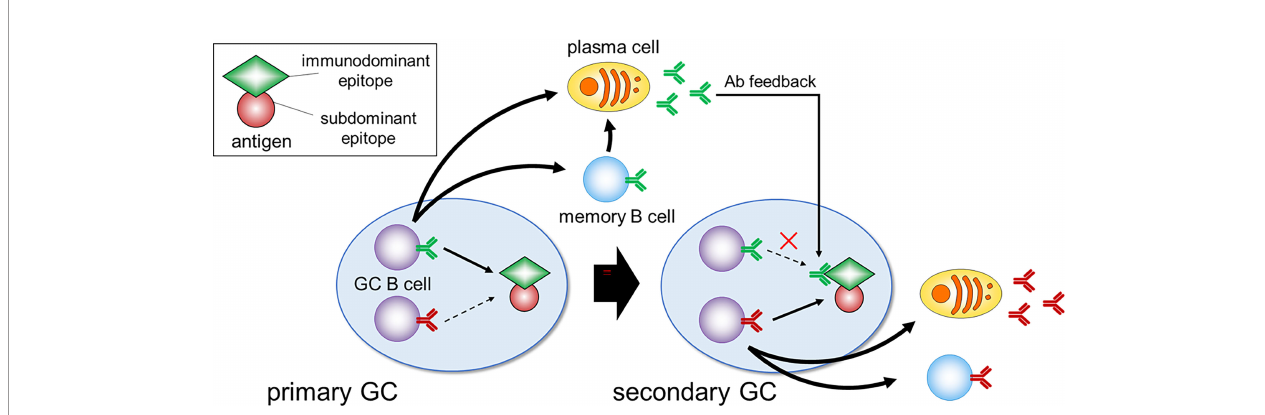
FIGURE 2 | Immunodominance and Ab feedback. In the primary GC, B cell clones speci fi c for the immunodominant epitopes dominate and give rise to plasma cells that secrete Ab. During the secondary GC response, this Ab masks its own epitope, which can suppress the expansion of immunodominant clones and enhance the selection of clones speci fi c for less accessible subdominant